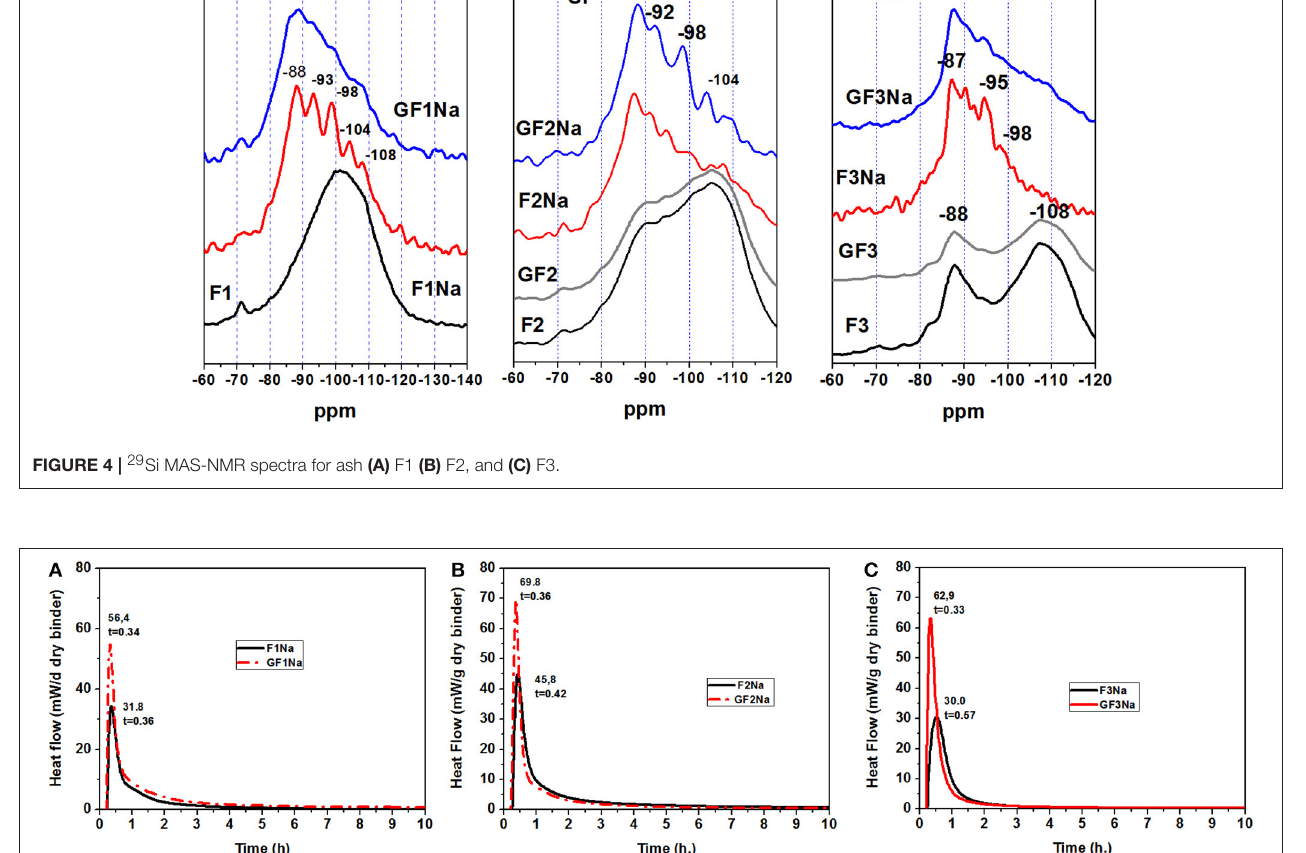
Frontiers in Materials | www.frontiersin.org